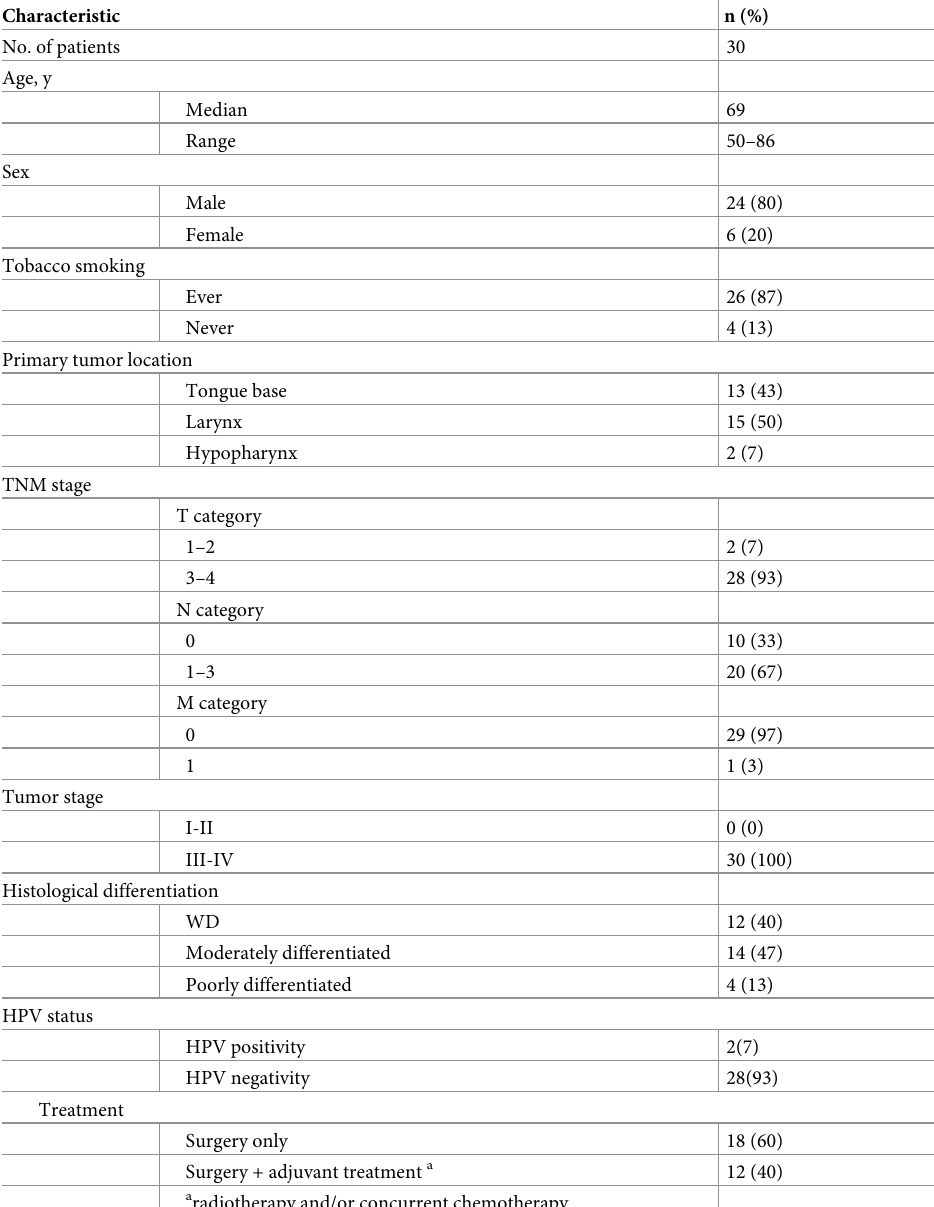
Table 1. Characteristics of the LC patients (n =